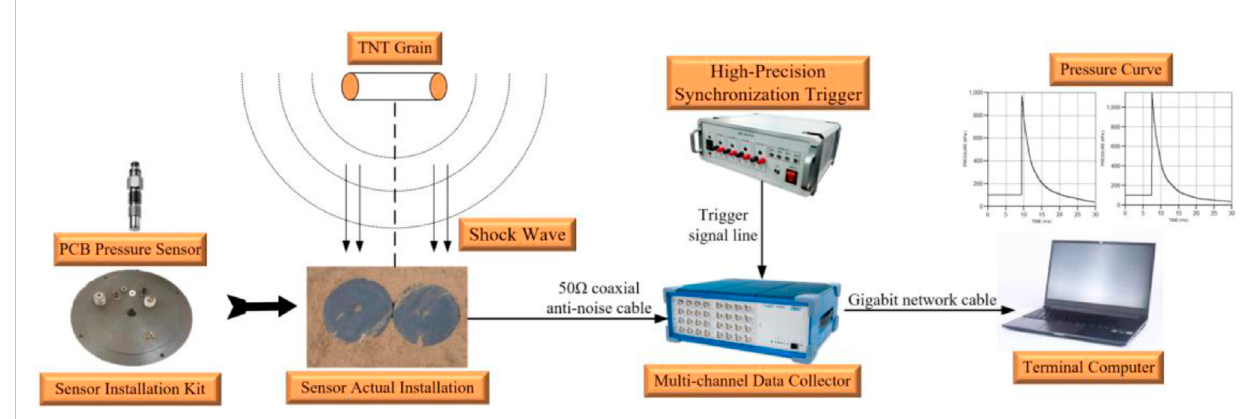
FIGURE 8 Surface re fl ection pressure measuring system.